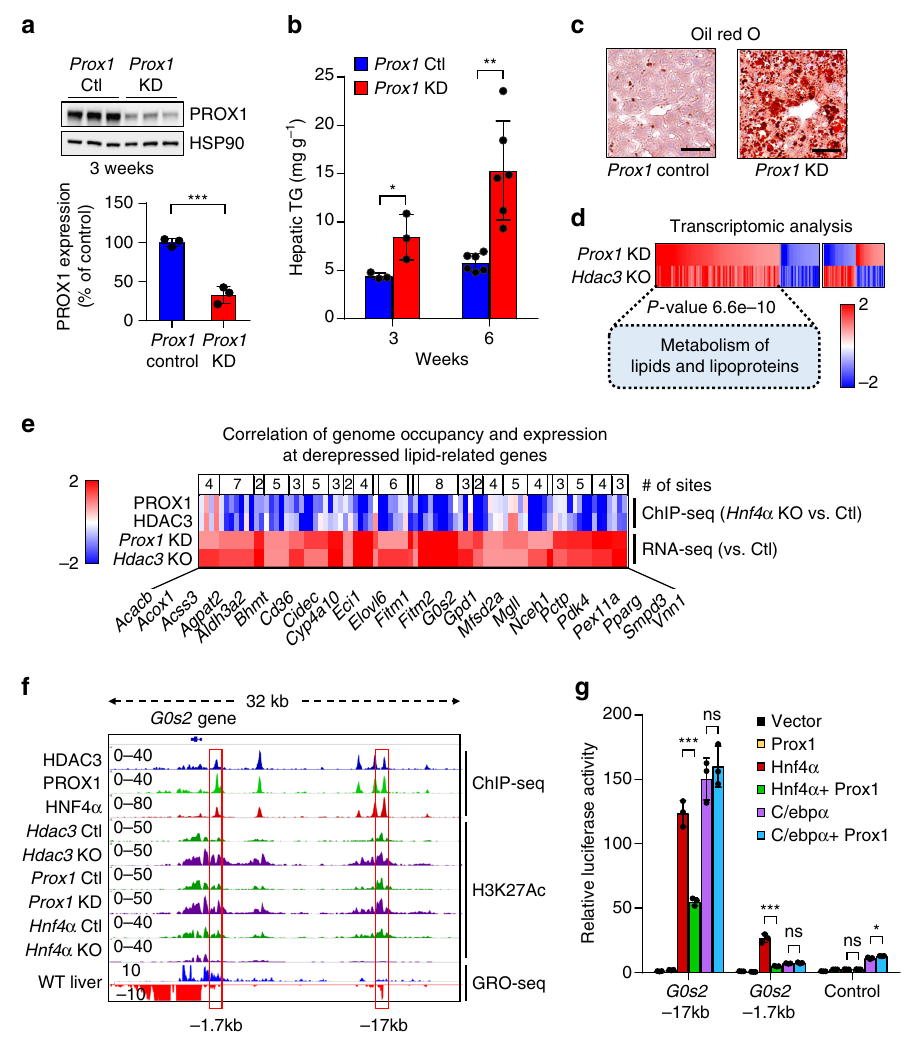
Fig. 4 The HDAC3 – PROX1 module suppresses steatosis by controlling a hepatic lipid metabolism gene program. a Western blot of liver samples from mice treated for 3 weeks with AAV8 TBG shLuciferase ( Prox1 Ctl) or shPROX1 ( Prox1 KD). Densitometry of the western blot shown above ( n = 3). Data are presented as mean ± s.d. b Hepatic triglyceride assay of livers infected for 3 weeks ( n = 3) or 6 weeks ( n = 6) with indicated virus. Data are presented as mean ± s.d. c Oil red O staining of livers infected for 6 weeks as in ( b ). Scale bar is 50 µ m. d RNA-seq analysis of Hdac3 fl / fl mice infected for 2 weeks with AAV8 TBG Egfp ( n = 2) or Cre ( Hdac3 KO, n = 3) vs. wild-type mice infected with AAV8 TBG shLuciferase ( n = 3) or shPROX1 ( Prox1 KD, n = 3)